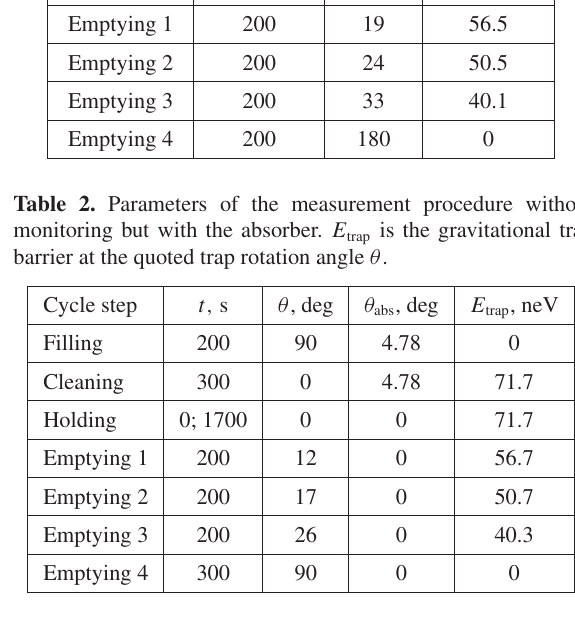
Table 1. The value of loss coefficient for fomblin